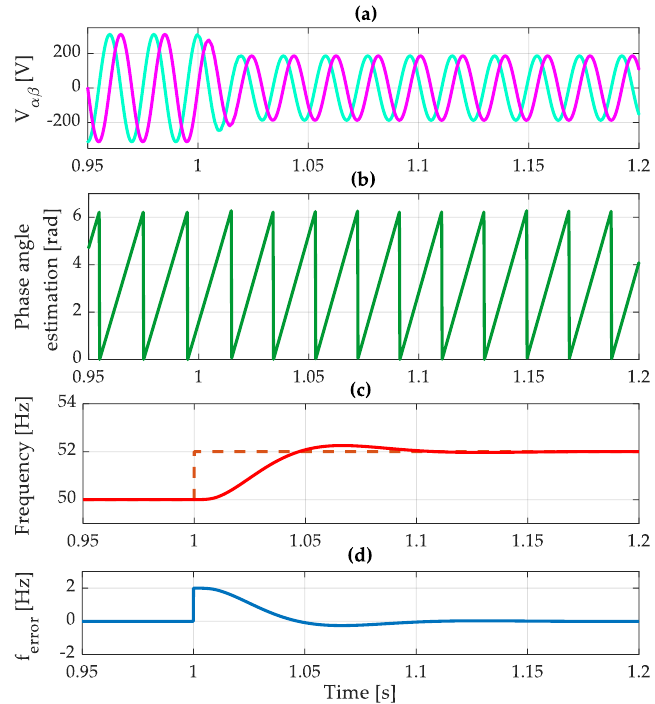
Figure 11. CDSC-PLL performance for scenario 1: αβ voltages ( a ), phase angle ( b ), frequency ( c ), and frequency error ( d ).